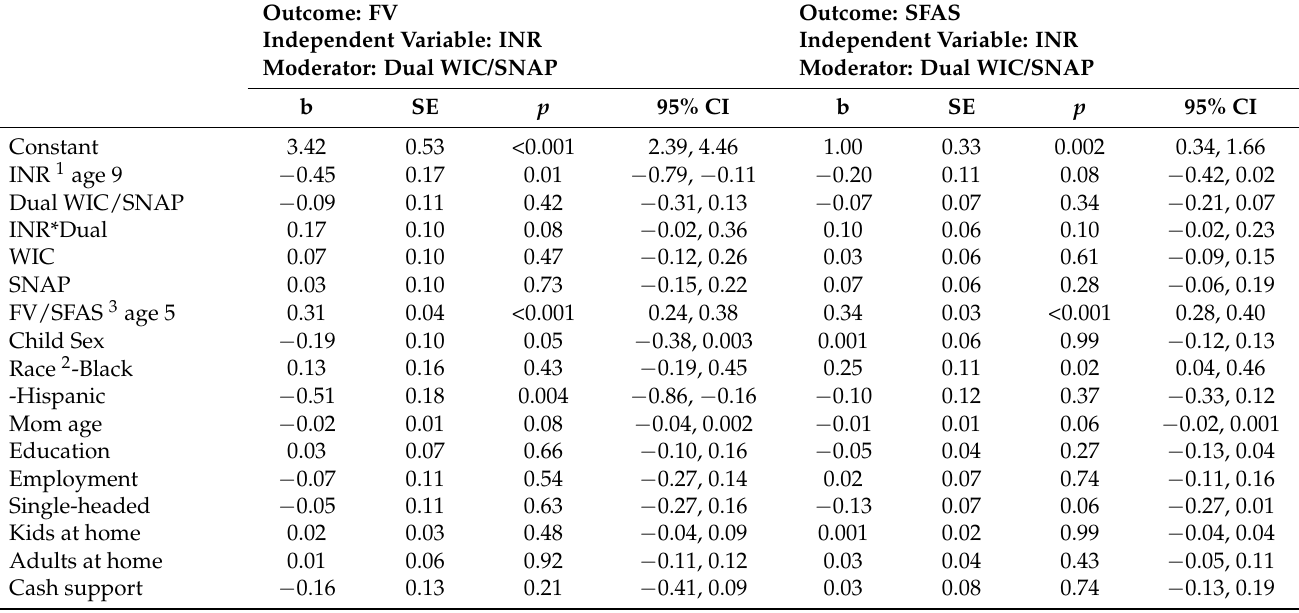
Table 5. A visualization of moderation effects is provided in Figure 1. Table 4. Accumulation of WIC and SNAP Dual Enrollment on Change in FV and SFAS Intake